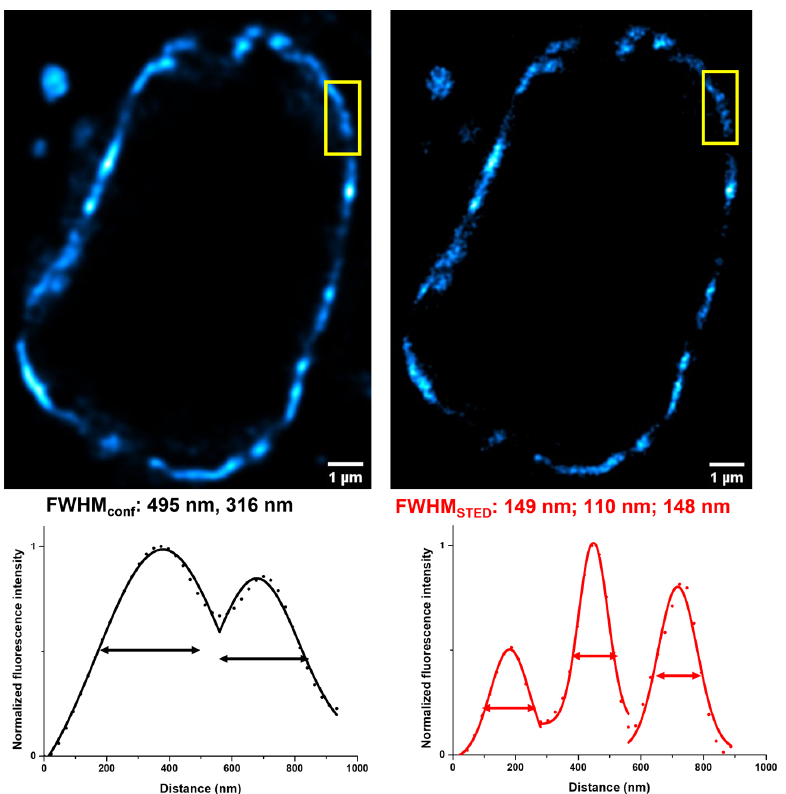
Figure 5. Confocal (left) and super-resolution (STED) (right) microscopy images of Lamin-HaloTag expressing HEK-293-OATP3A1 cells pretreated with HaloBCN (3 µ M, 60 min) and treated with non-permeable fluorescent dye CBRD4-BAT (10 µ M, 30 min) (cyan) in complete DMEM medium. Scale bar: 1 μ m; Spectral detection: CBRD4 ‐ BAT ; λ exc : 552 nm/ λ em : 565–800 nm; depletion laser: 660 nm; Objective: 100×. Line diagram of the indicated area is characterized with full width at half maxima values (FWHM).